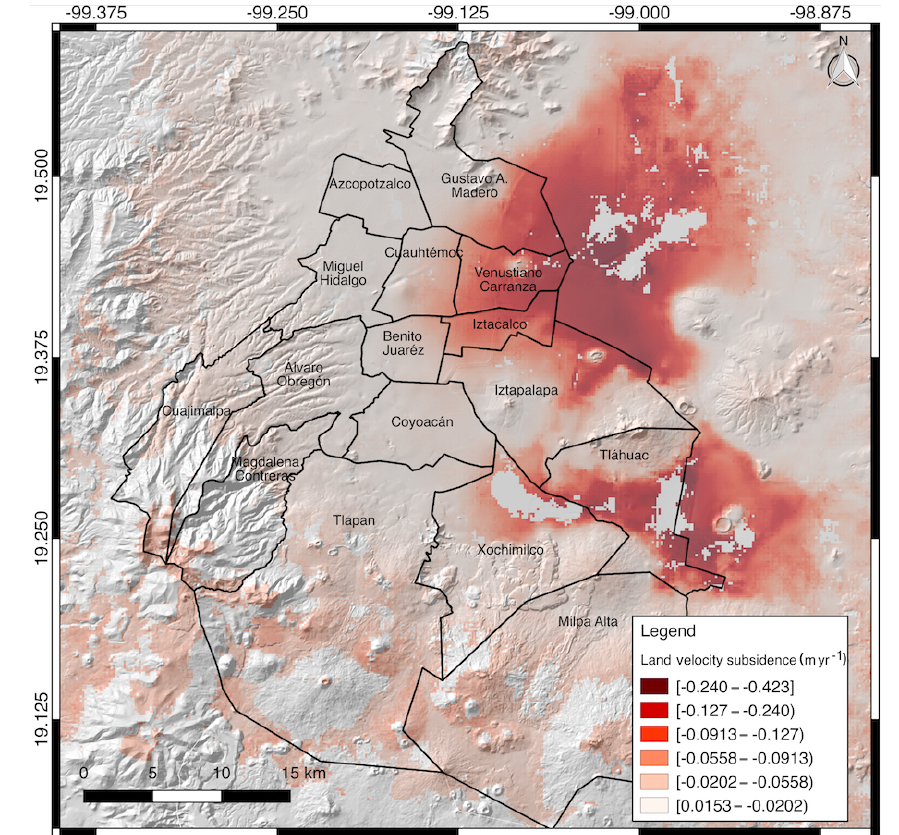
Figure 1. Subsidence velocity map for Mexico City and its municipalities (black lines) derived from the interferometric analysis of Sentinel- 1 SAR data between November 2014 and November 2017. Black lines show Mexico City’s municipalities. The shaded topographic base layer is taken from Continuo de Elevaciones Mexicano 3.0 © Instituto Nacional de Estadística Geografía e Informática